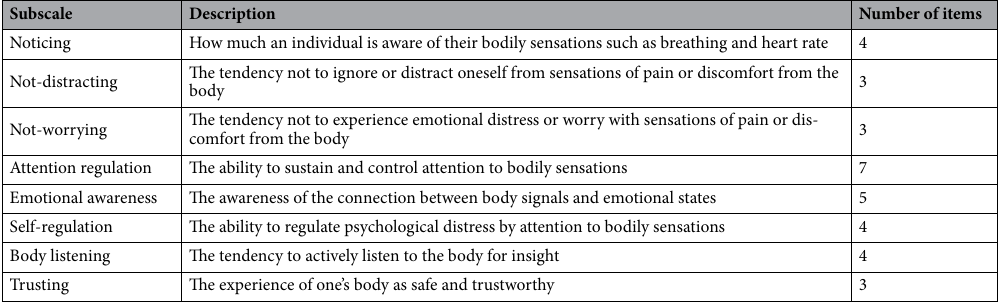
Table 3. Subscales of the MAIA.